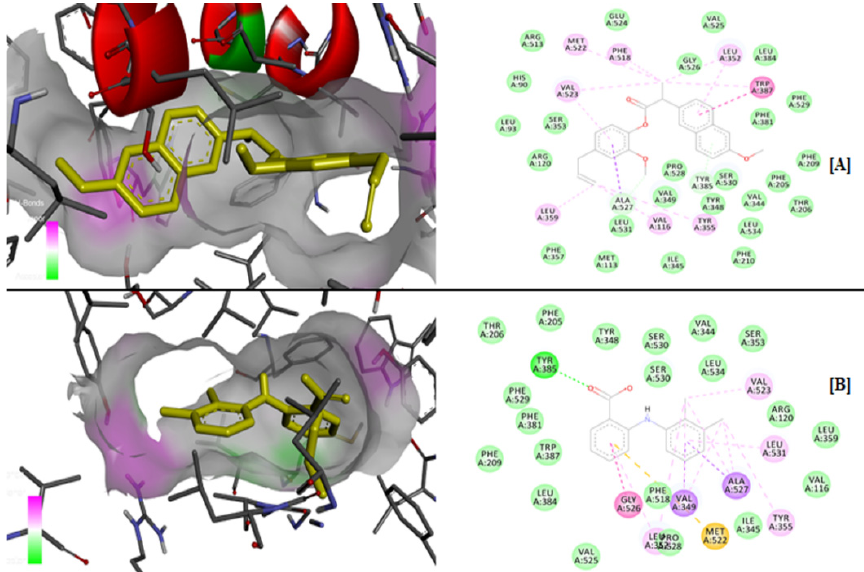
Figure 2. Two- and three-dimensional binding conformation of ( A ) designed chimera MAS-1696 and ( B ) standard drug S-naproxen against human COX2 enzyme. The interactions shown in pink color refer to pi interactions; the green color refers to van der Waals interactions, and light green refers to hydrogen bonding.